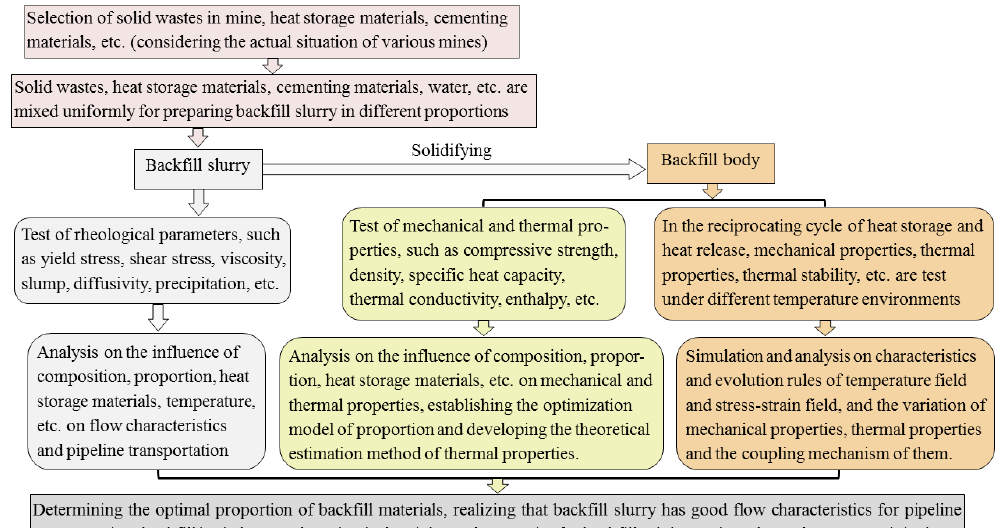
Figure 4. The optimized proportion of backfill slurry on mechanical and thermal properties of the backfill body. backfill